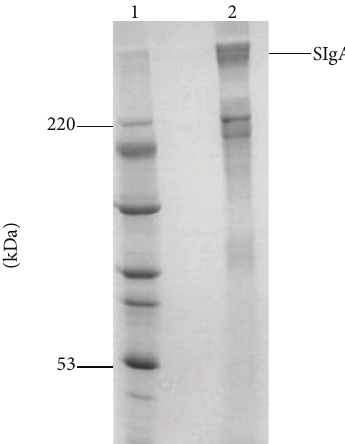
Figure 5: SDS-PAGE analysis of purified SIgA under non-reducing conditions. Lane 1: protein molecular weight marker; 2: purified SIgA antibody.